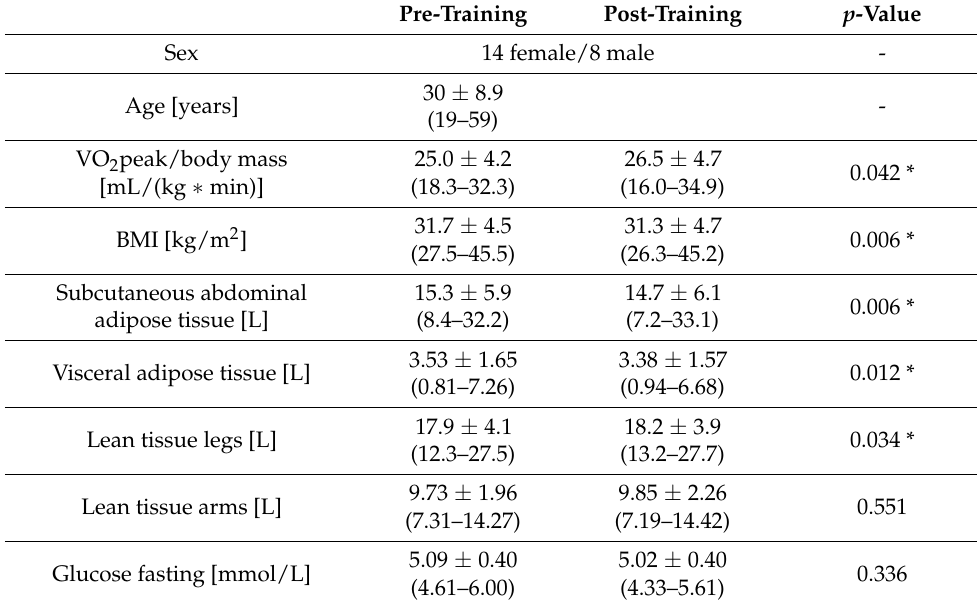
Table 1. Anthropometric, fitness and metabolic